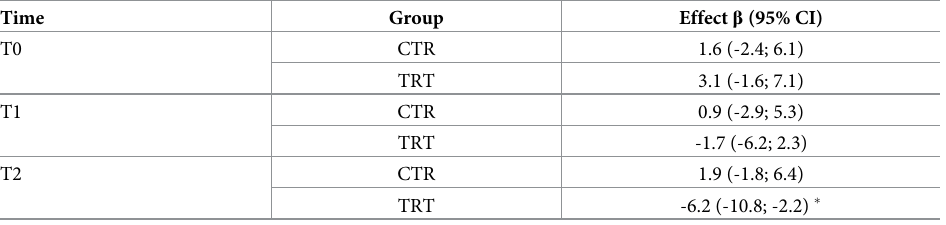
Table 5. Effect ( β ) of time on HCPI scores recorded in the two groups (CTR and TRT) estimated by the per- formed